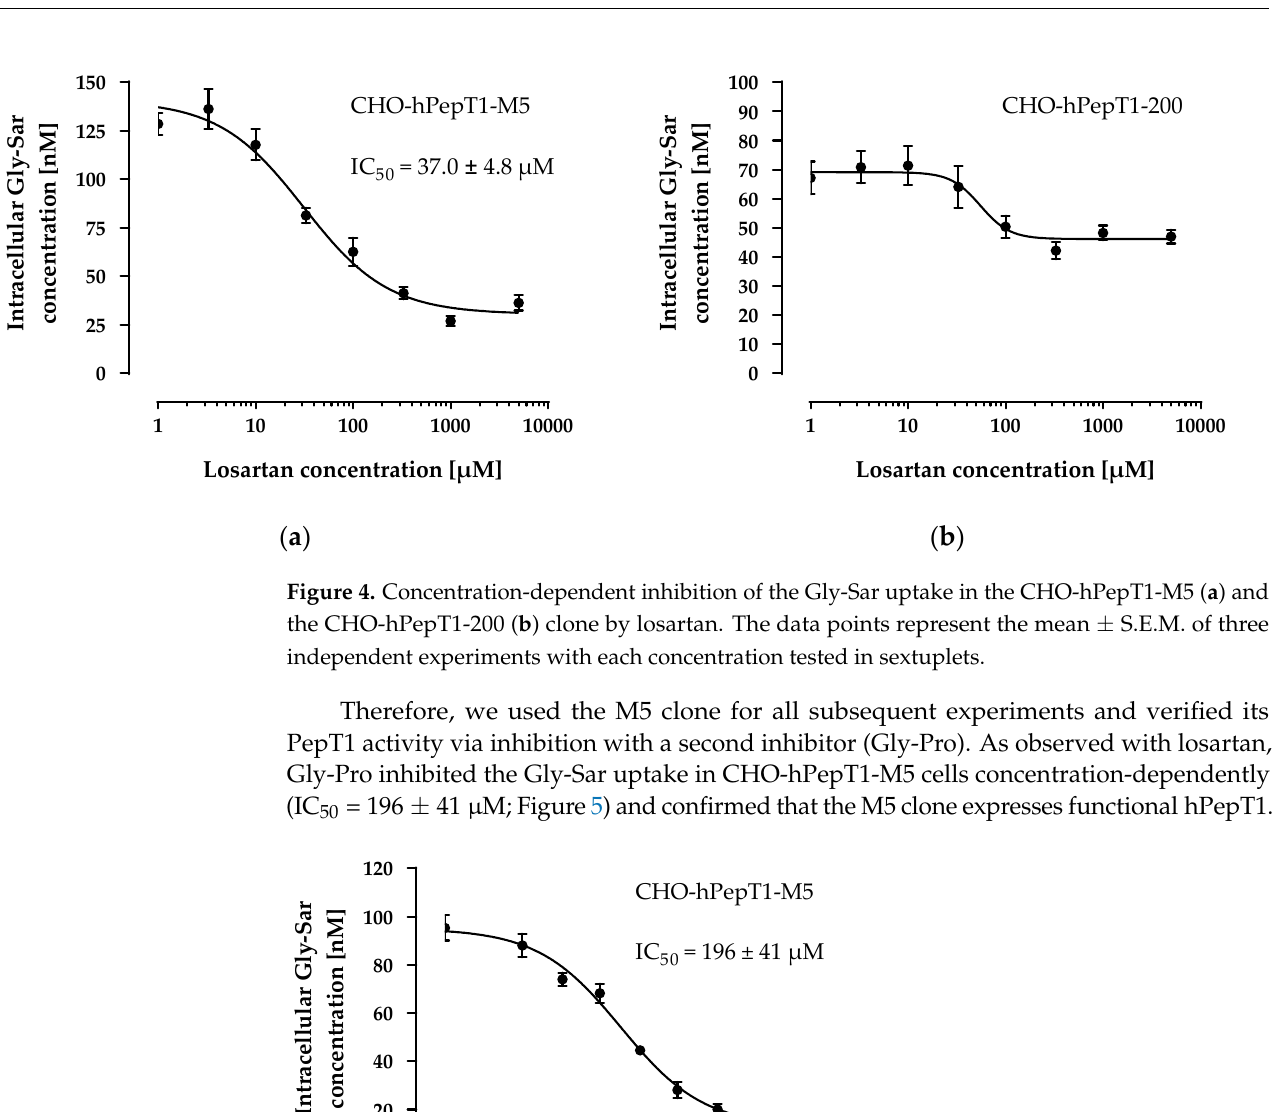
Figure 3. Uptake of Gly-Sar in CHO-K1, CHO-hPepT1-200, and CHO-hPepT1-M5 clones. The data points represent the mean ± S.E.M. of three independent experiments with each concentration tested in triplets.